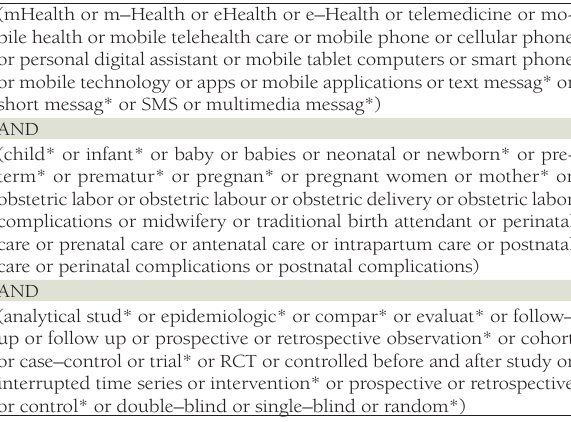
(mHealth or m–Health or eHealth or e–Health or telemedicine or mo- bile health or mobile telehealth care or mobile phone or cellular phone or personal digital assistant or mobile tablet computers or smart phone or mobile technology or apps or mobile applications or text messag* or short messag* or SMS or multimedia messag*) AND (child* or infant* or baby or babies or neonatal or newborn* or pre- term* or prematur* or pregnan* or pregnant women or mother* or obstetric labor or obstetric labour or obstetric delivery or obstetric labor complications or midwifery or traditional birth attendant or